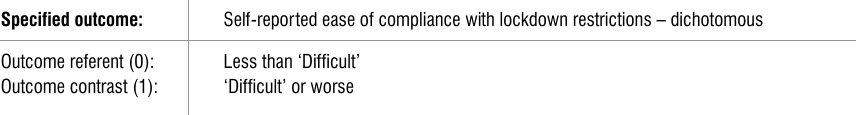
The socio-demographic and economic determinants of ease of compliance with COVID-19 restrictions; and the relationship between ease of compliance and COVID-19 related illness and job/business/income loss – both before (Column 3.1) and after (Column 3.2) adjustment for any preceding potential/candidate confounders. All results are presented as odds ratios (ORs) with 95% confidence intervals in parentheses (95%